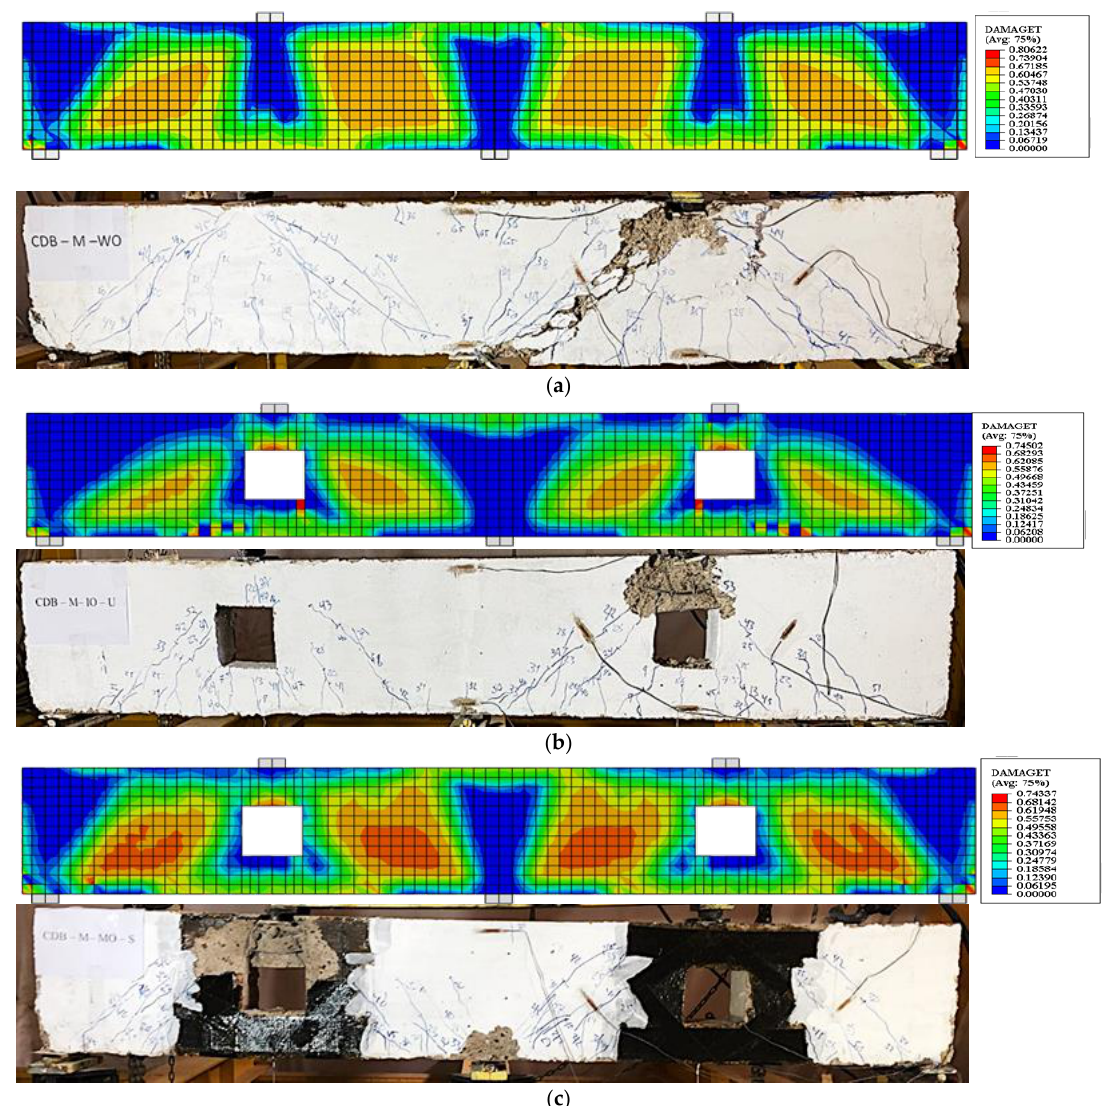
Figure 11. Crack patterns of the tested specimens in experimental setup and ABAQUS. ( a ) Specimen CDB – Solid; ( b ) specimen CDB – O – U; ( c ) specimen CDB – O – S.